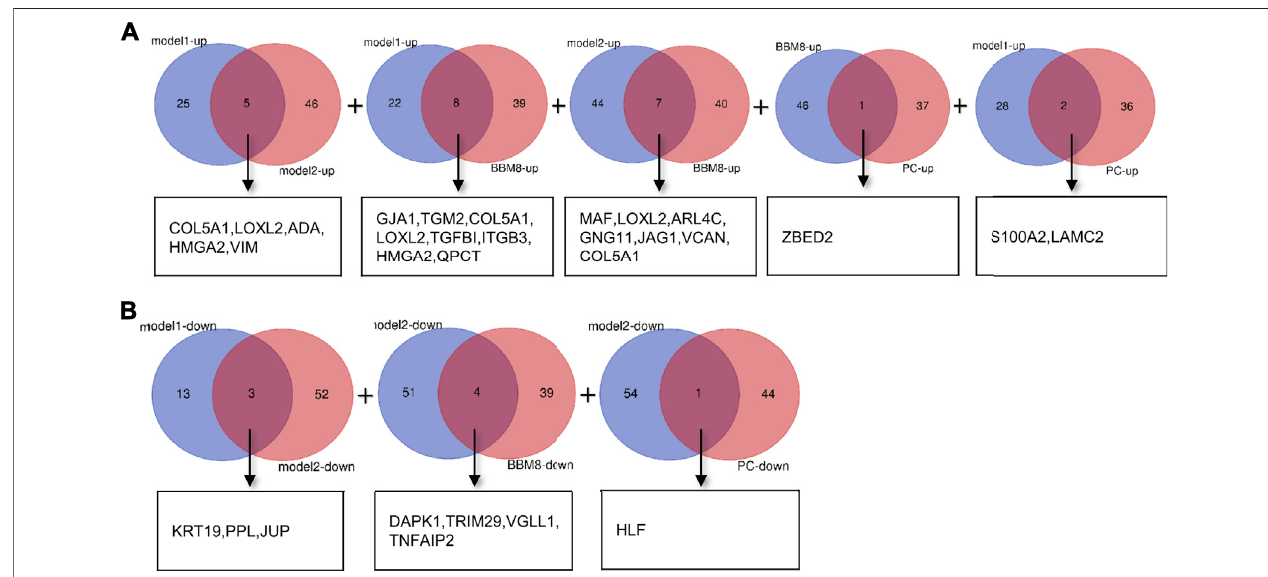
FIGURE 3 | Gene screening (A) Intersection of differentially upregulated genes of Model 1, Model 2, BxPC-3 and BxPC-3-M8, and TCGA pancreatic cancer samples, respectively. No differentially up-regulated genes were shared between Model 2 and TCGA pancreatic cancer samples (B) Intersection of differentially down- regulatedgenesofModel1,Model2,BxPC-3andBxPC-3-M8,andTCGApancreaticcancersamples,respectively.Nodifferentiallydown-regulatedgeneswereshared between Model 1 and BxPC-3, and BxPC-3-M8 and TCGA pancreatic cancer samples, and between BxPC-3 and BxPC-3-M8 and TCGA pancreatic cancer samples.